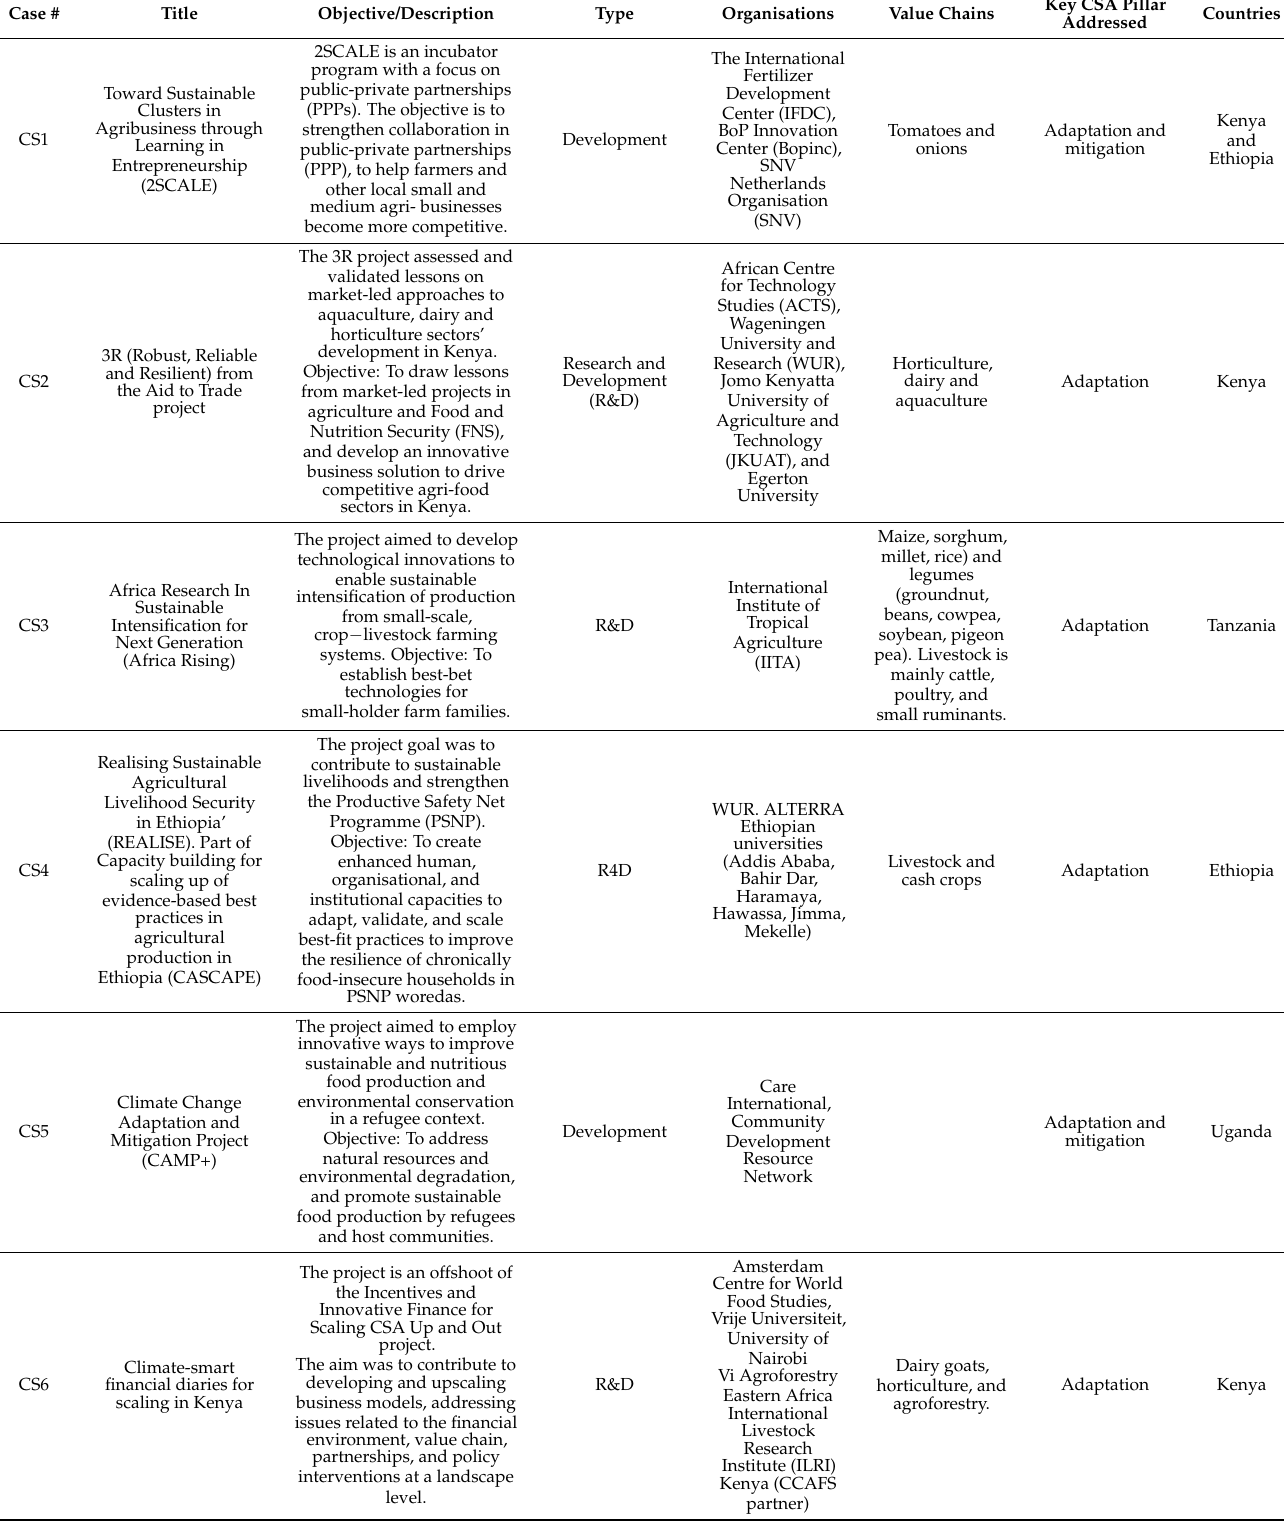
Table 2. General description of case